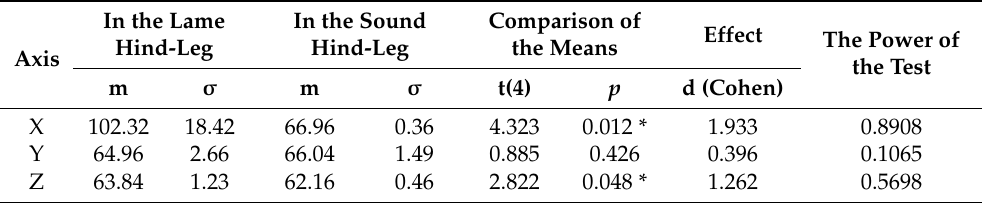
Table 4. Comparison between the mean number of impulses recorded on the accelerometers’ axes for the five assessed steps in the lame and sound contralateral hindleg of the studied horses ( n = 5). In the Lame In the Sound Comparison of Effect The Power of Hind-Leg Hind-Leg the Means Axis the Test m σ m σ t(4) p d (Cohen) X 102.32 18.42 66.96 0.36 4.323 0.012 * 1.933 0.8908 Y 64.96 2.66 66.04 1.49 0.885 0.426 0.396 0.1065 Z 63.84 1.23 62.16 0.46 2.822 0.048 * 1.262 0.5698